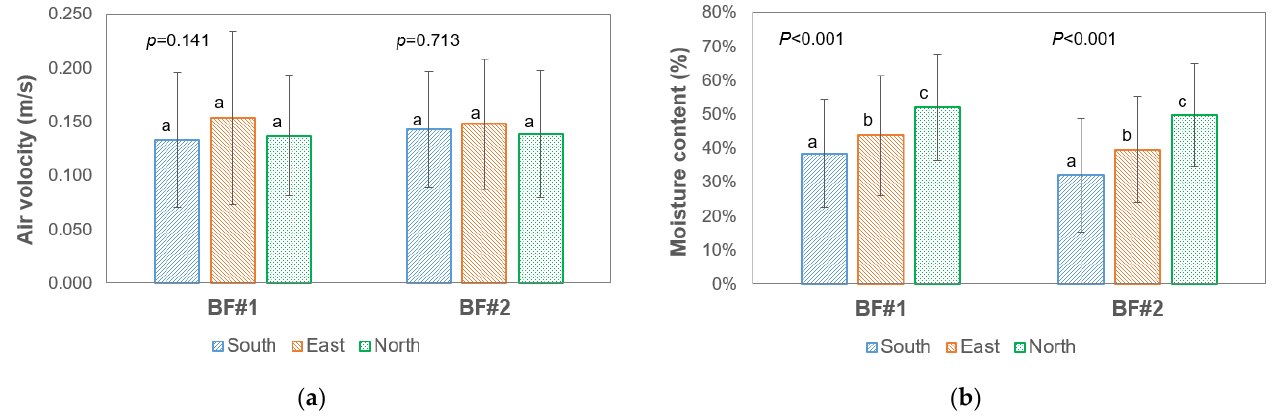
Figure 3. ( a ) Average air velocity and ( b ) average woodchip moisture content on the south, east, and north sides of each biofilter. Non-parametric ANOVA was performed for comparison. The sides annotated with the same letter were not significantly different.